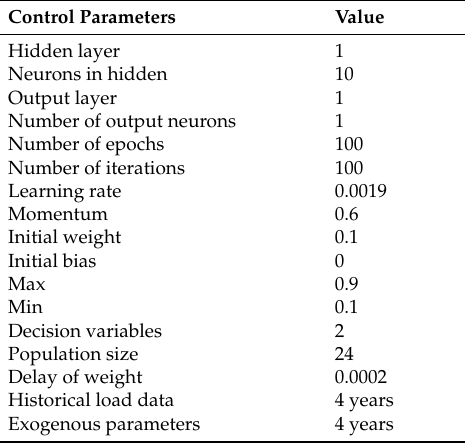
Table 2. Simulation